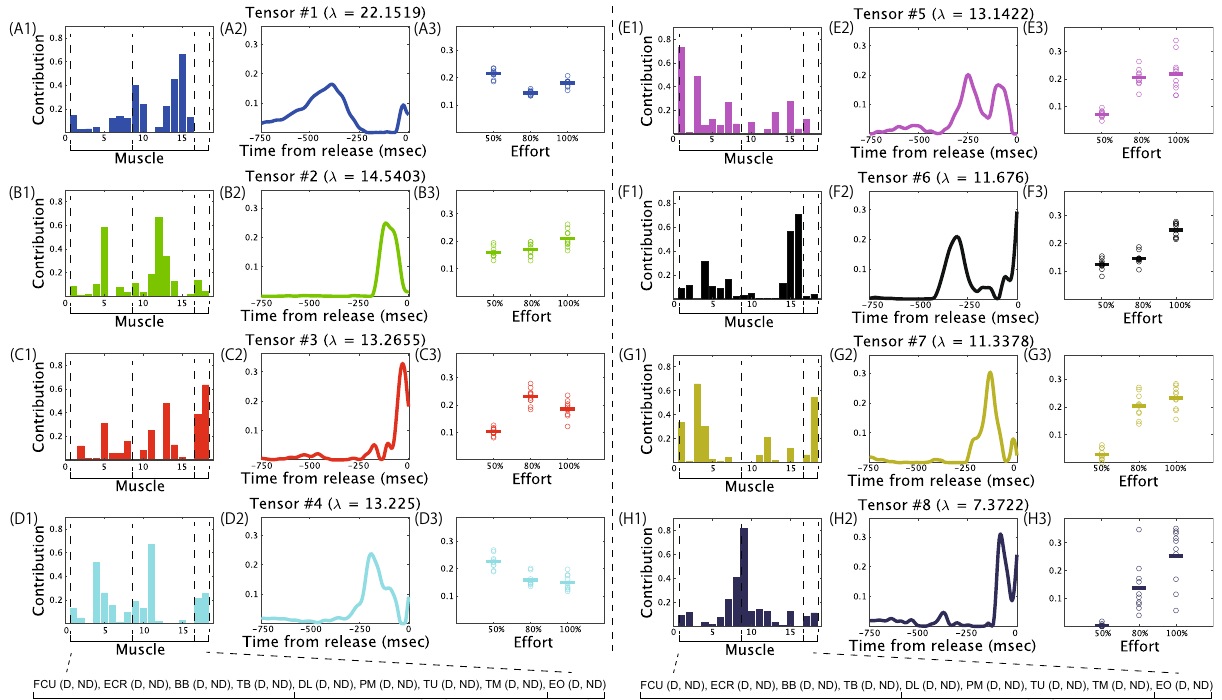
Figure 3. Spatial modules, temporal modules, and trial components extracted via CP decomposition with nonnegative constraints in a typical subject. (cid:31) indicates the contribution of each tensor in reconstructing the original data (detailed descriptions were provided in the Materials and methods section). Each color indicates the associated combinations of the spatial module, temporal module, and trial component. For example, the blue-colored spatial module in panel A1 is associated with the blue-colored temporal module in panel A2 and the blue-colored trial component in panel A3. (A1–H1): Extracted spatial modules. Horizontal and vertical axes indicate the muscle number and the recruitment of each muscle in the spatial module. Each muscle number corresponds to the name listed at the bottom part of this figure. The definitions for the abbreviated muscle names in the bottom part of this figure are listed in Table 1. The abbreviations D and ND associated with each muscle indicate the dominant and nondominant side. (A2–H2): Extracted temporal modules. Horizontal and vertical axes indicate the time frame number and the recruitment magnitude. (A3–H3): Extracted trial components. Horizontal and vertical axes indicate the effort type and the magnitude of the trial component. The trial component in each trial is shown as a dot. The horizontal solid lines indicate the trial component averaged across trials in each level of effort. Larger values in the component indicate larger recruitment of the associated spatial and temporal modules in that level of